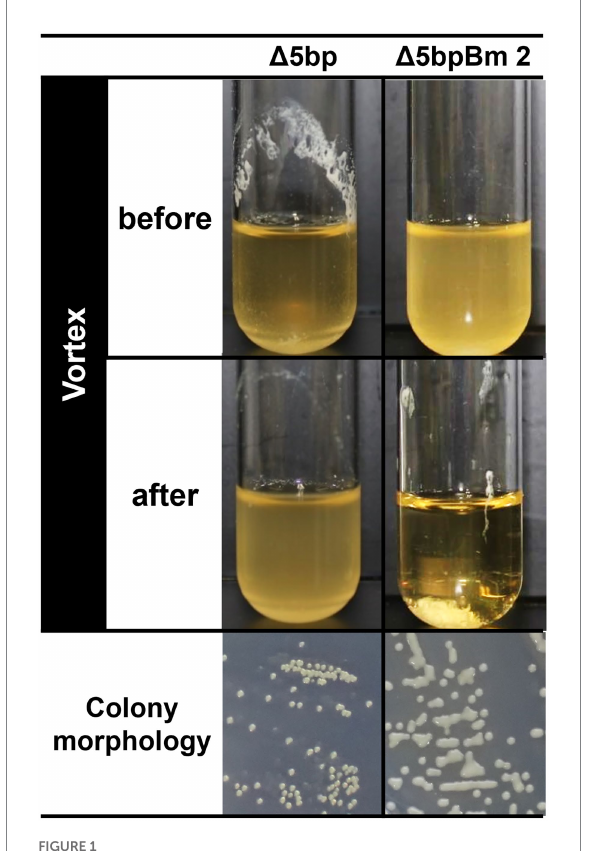
FIGURE 1 Autoaggregation assay of S. aureus FK300 5 bp deletion mutant culture. Autoaggregation assay of S. aureus FK300 5-bp deletion mutant culture. During the process of isolating the 5-bp ( icaR - icaA intergenic region) deletion mutant from S. aureus FK300, we obtained colonies showing a distinct phenotype and the